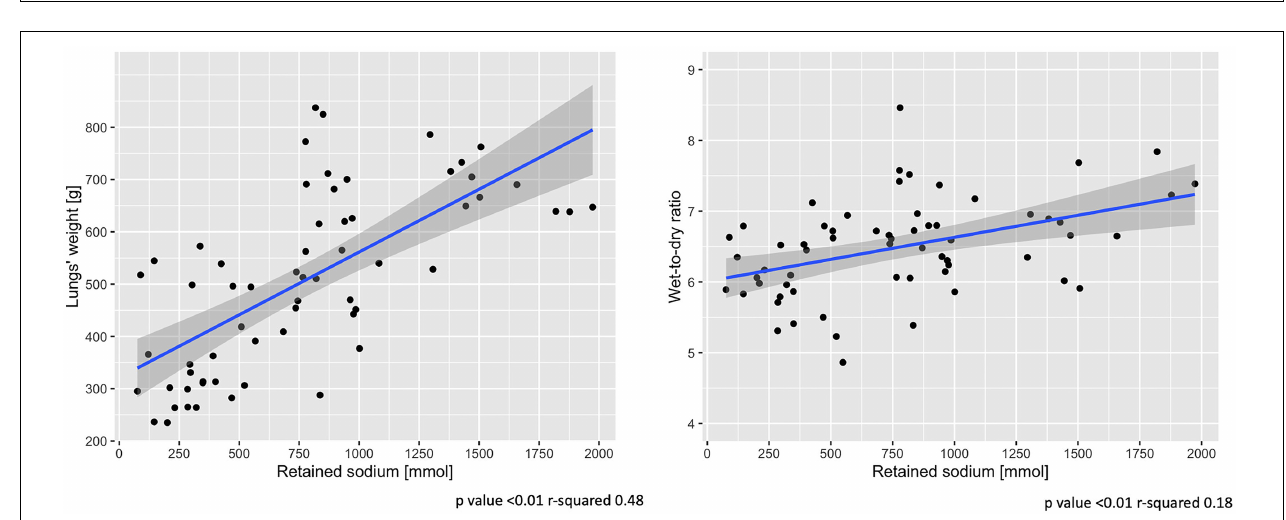
FIGURE 5 | End-of-experiment association between lung-weight and wet-to-dry ratio vs. retained sodium. Scatter-plot of measures obtained at 48 h. Statistic: linear logistic regression. Data available in 62 animals for lungs’ weight and wet-to-dry